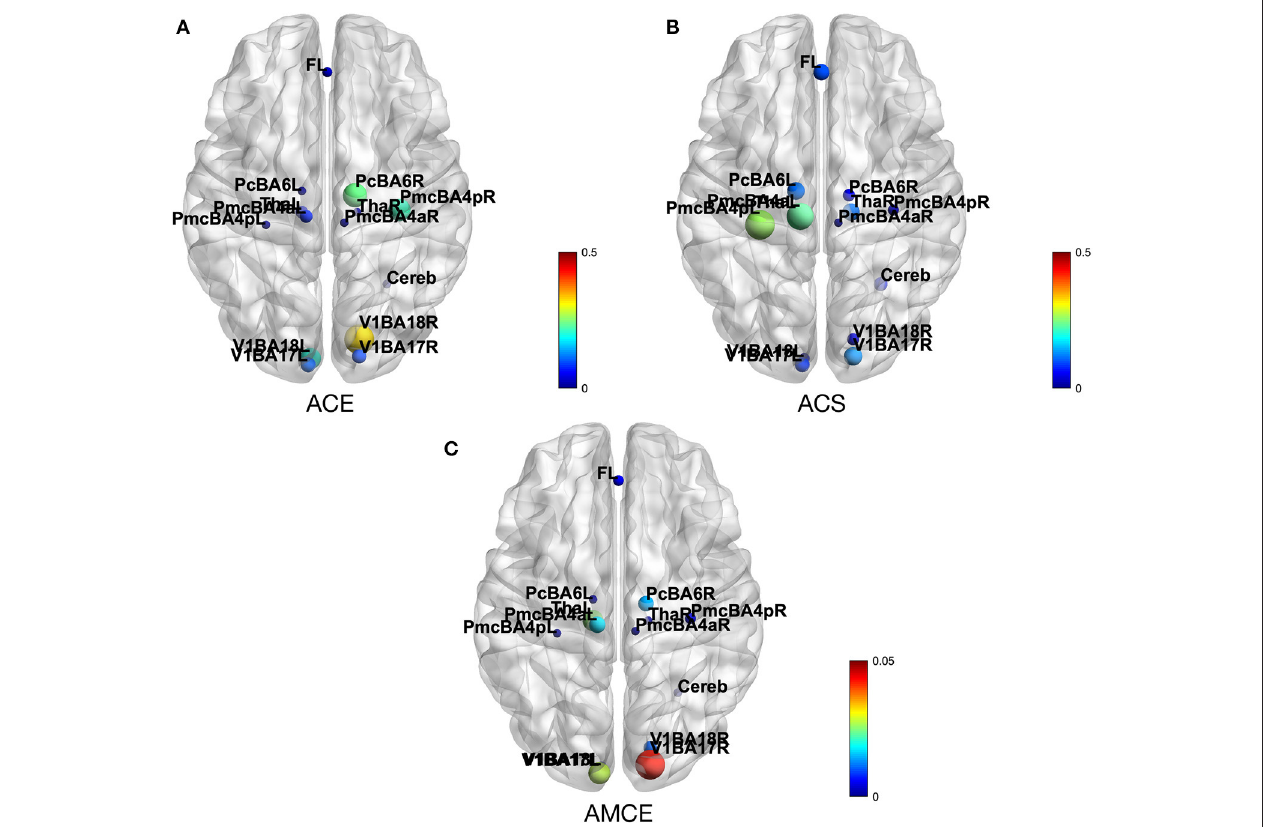
FIGURE 5 | (A) Depicts the average causal effect (ACE) of each brain region (nodes) in HCP motor task-fMRI connectivity model. The values (size of the nodes) reflect how much a particular region effects the rest of the brain. (B) Average causal susceptibility (ACS) shows how sensitive the region is to the change from the rest of the system. (C) Average mediated causal effect (AMCE) shows how strong the region mediates the effect